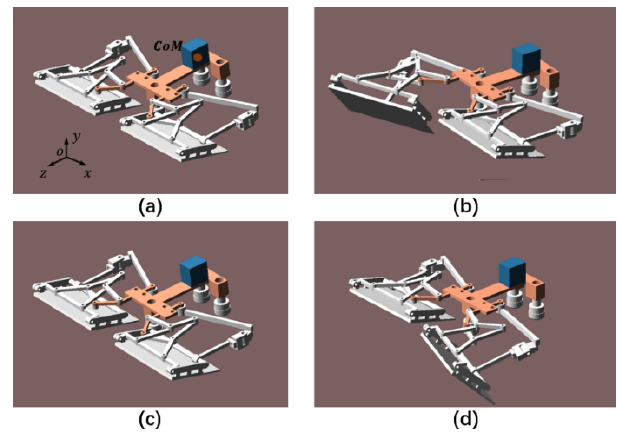
Figure 12. The sprawling locomotion actuated by the designed